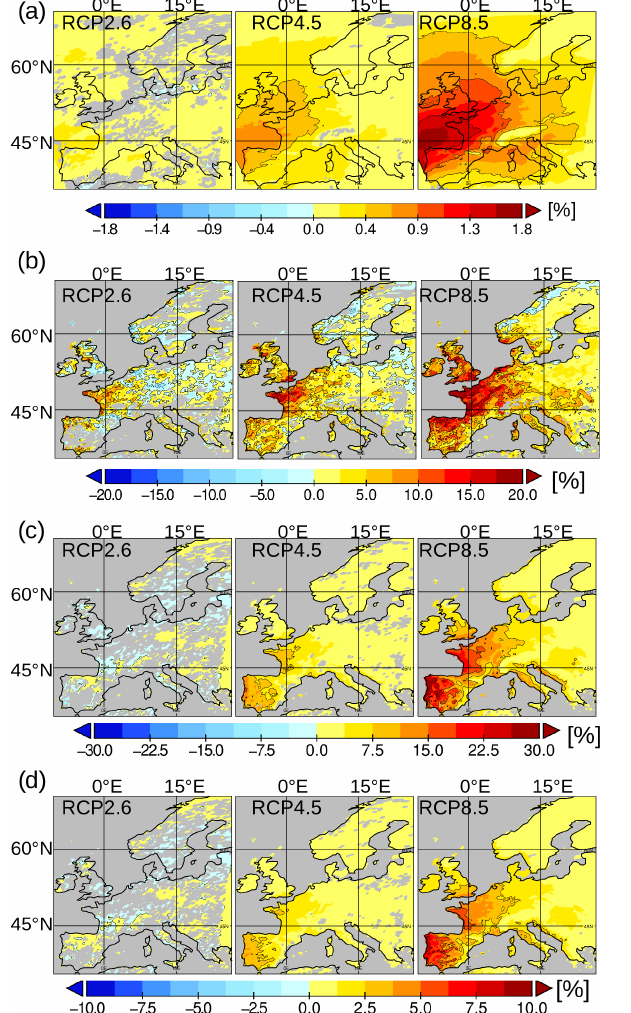
Figure 8. Difference between 2070–2099 minus 1970–1999 (i.e., the % values for the future minus the % values for the his- torical). (a) ARF, (b) AR-forced yearly maximum precipitation rates (%AMP), and (c) change in the AR fractional contribution to the heavy precipitation (%95 P ). (d) Same as panel (c) but for the fraction to the annual total precipitation (%TP). Note that all non-robust changes (at least 66% of downscaled runs agree on the sign of change) have been masked out. Shown are ensemble mean